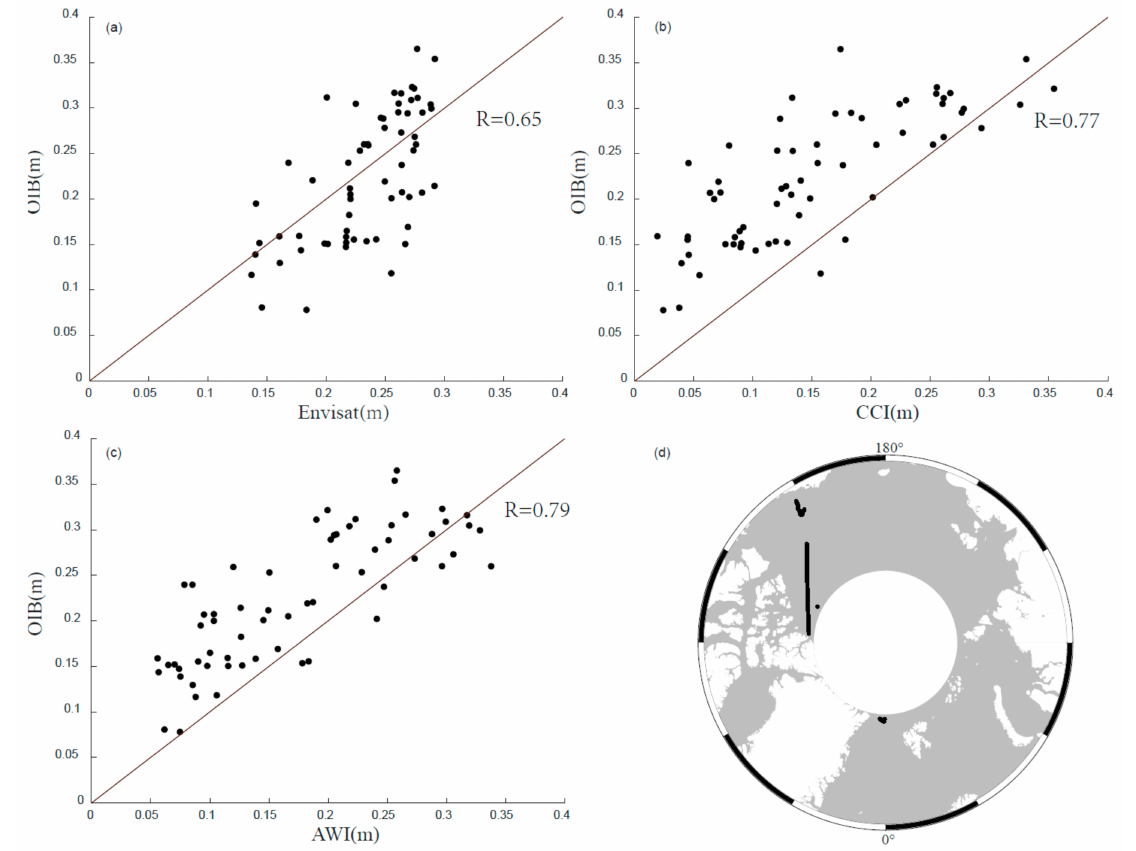
Figure 9. Scatterplots of the sea ice freeboard from this study and that from the two products versus that from Operation IceBridge (OIB): ( a ) this study vs. OIB, ( b ) CCI vs. OIB, ( c ) AWI vs. OIB. ( d ) illustrates the OIB tracks (black lines) within the Envisat mission